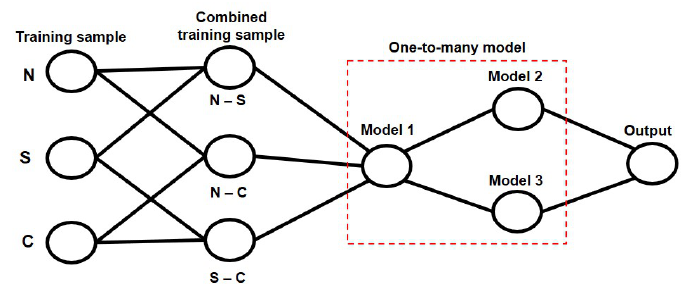
Figure 3. Cause estimation model formation and